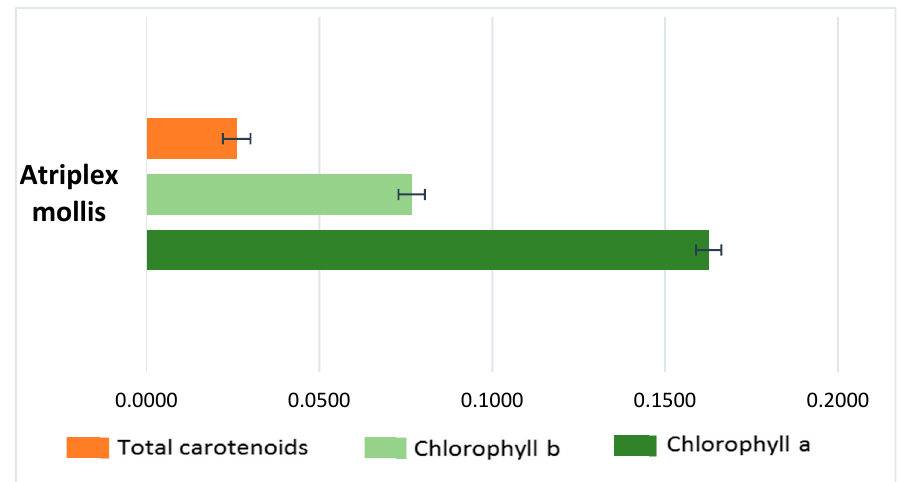
Figure 3. Pigment content in A. mollis aerial parts extract (µg/mg DW ± SD).